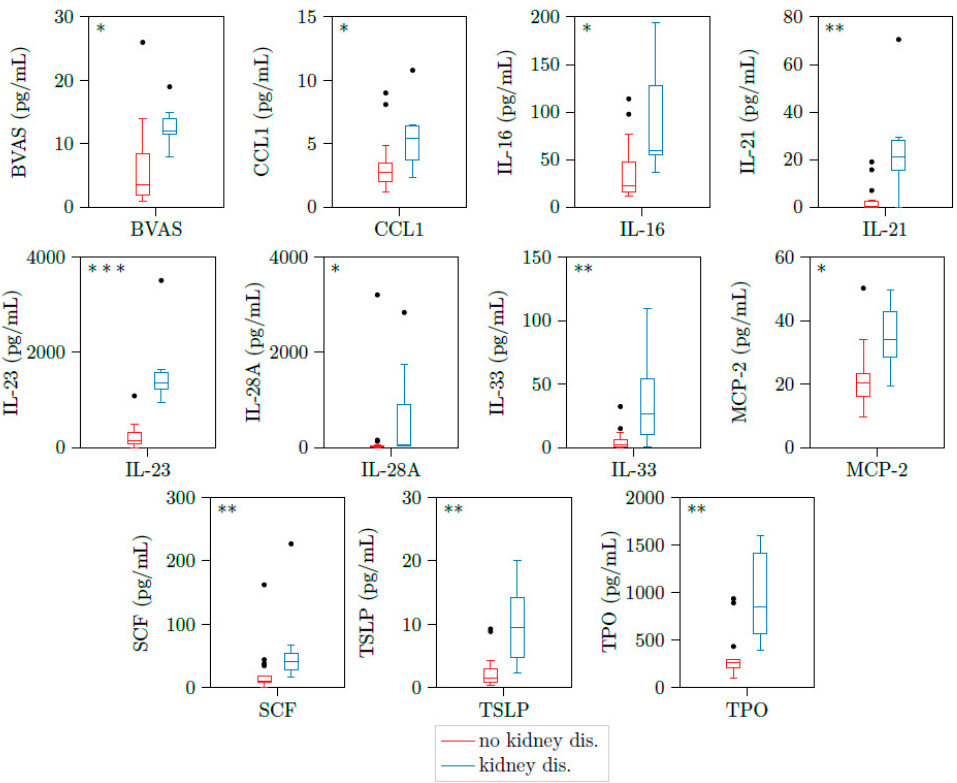
Figure 2. CCL1, IL16, IL21, IL23, IL28A, IL33, MCP2, SCF, TSLP, and TPO are upregulated in patients with active ANCA- associated vasculitis and kidney involvement. Illustration of BVAS, CCL1, IL16, IL21, IL23, IL28A, IL33, MCP2, CSF, TSLP, and TPO plasma concentrations of 23 samples with active PR3-AAV. All cytokines were significantly elevated in patients with kidney involvement ( n = 7) versus those without kidney involvement ( n = 16). * p < 0.05; ** p < 0.01, *** p < 0.001, boxes and whisker plots present distribution of the median, the upper and lower quartile, the whiskers with 1.5 of the interquar- tile distances, as well as the outliers.